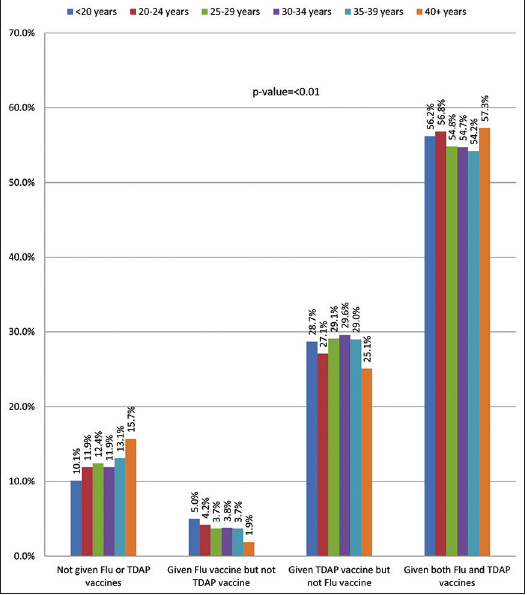
Figure 1 : Flu and TDAP vaccine acceptance by patient’s age